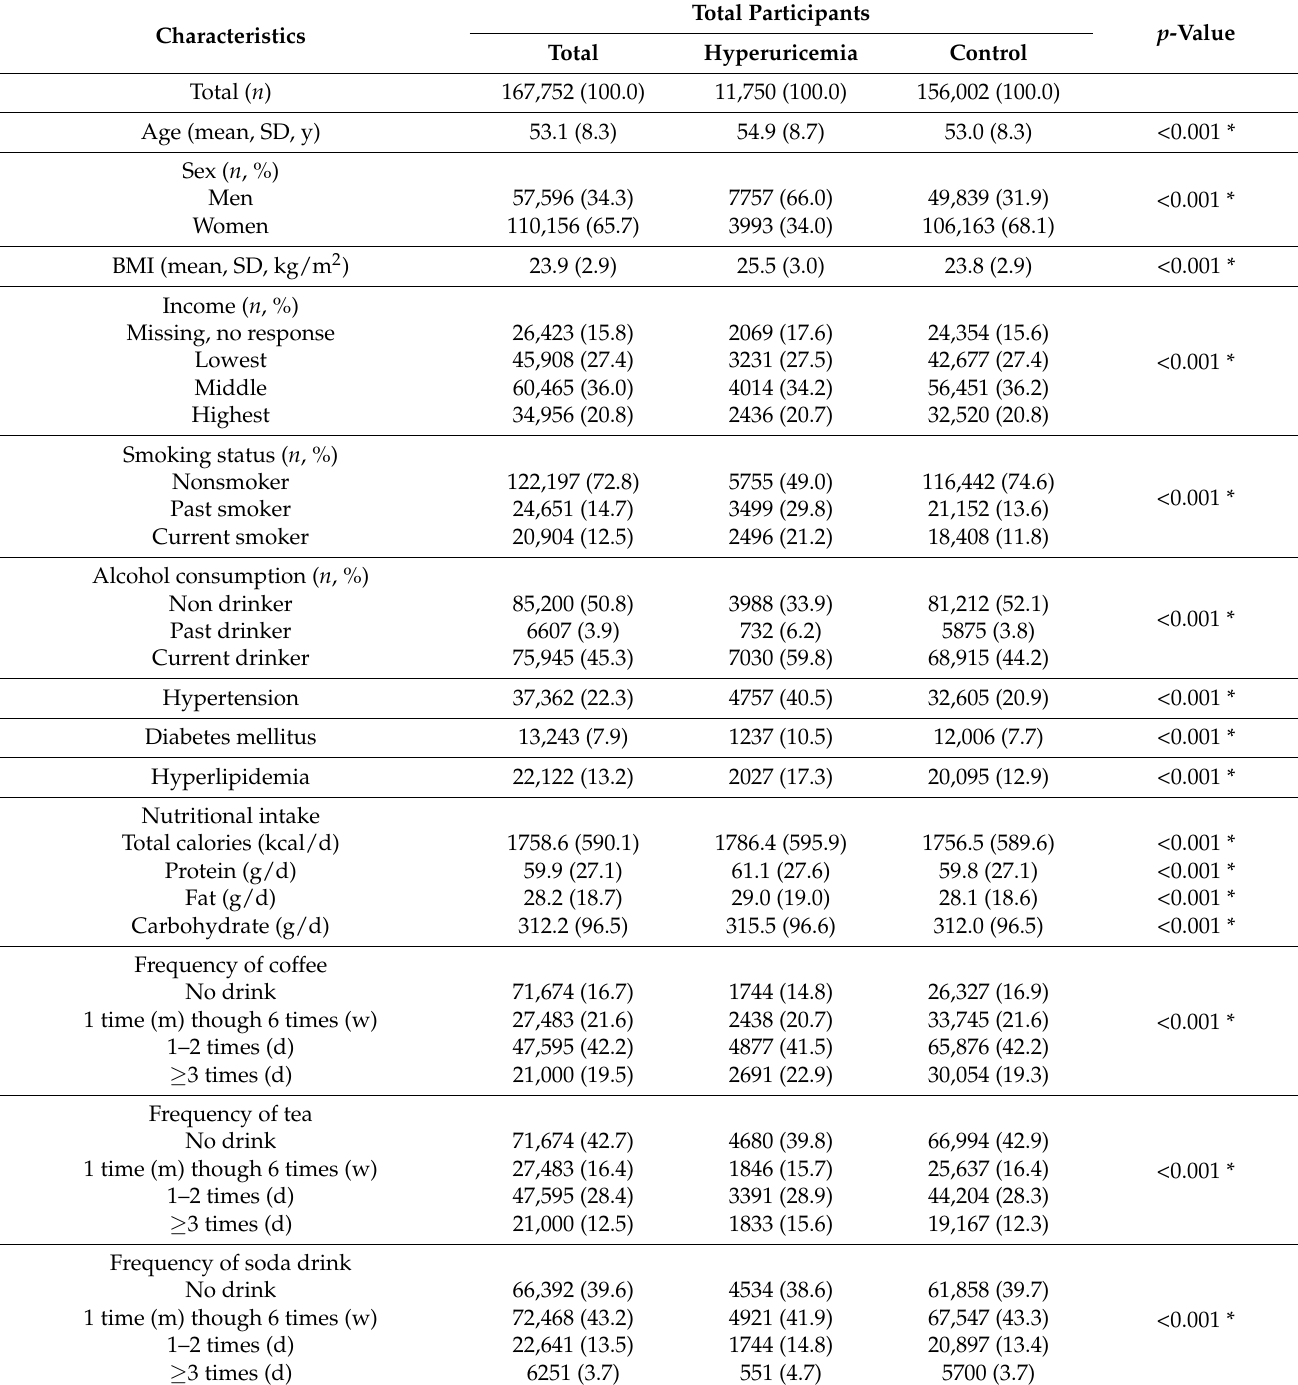
Table 1. General Characteristics of